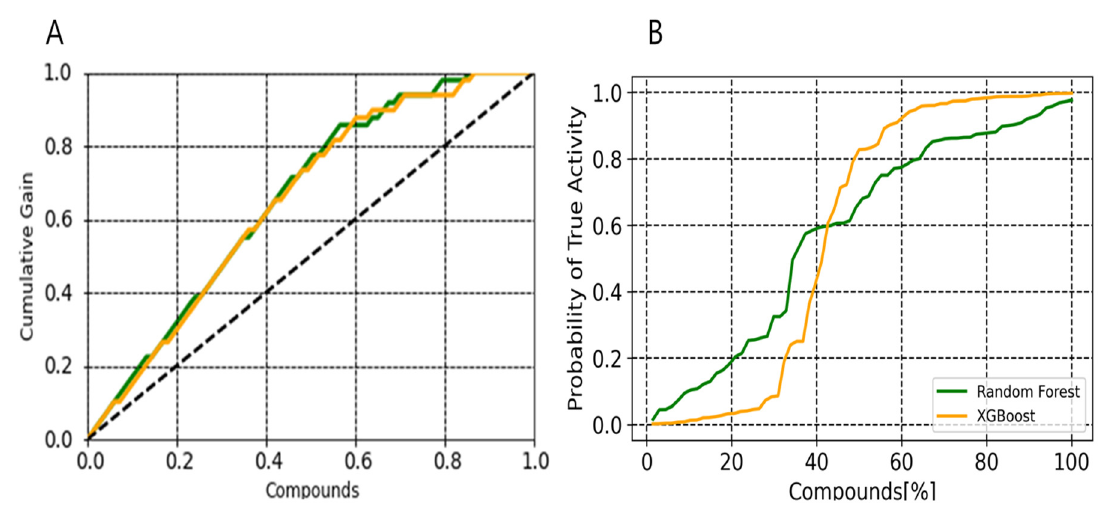
Figure 7. Probabilistic distribution plots. ( A ) Cumulative gain plot for random forest (green line) and XGBoost (orange line) models ( B ) Predictiveness curves. Both the plots were plotted using the selected descriptor set.